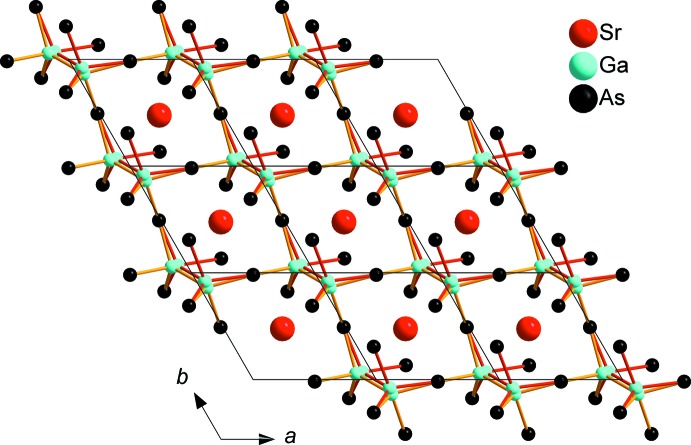
Corner-sharing Ga2As6 dumbbells with disordered Ga positions forming a honeycomb-like layer viewed along [001].